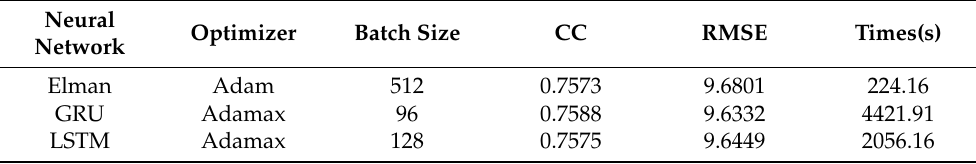
Table 4. Best hyperparameters for PM 2.5 particle